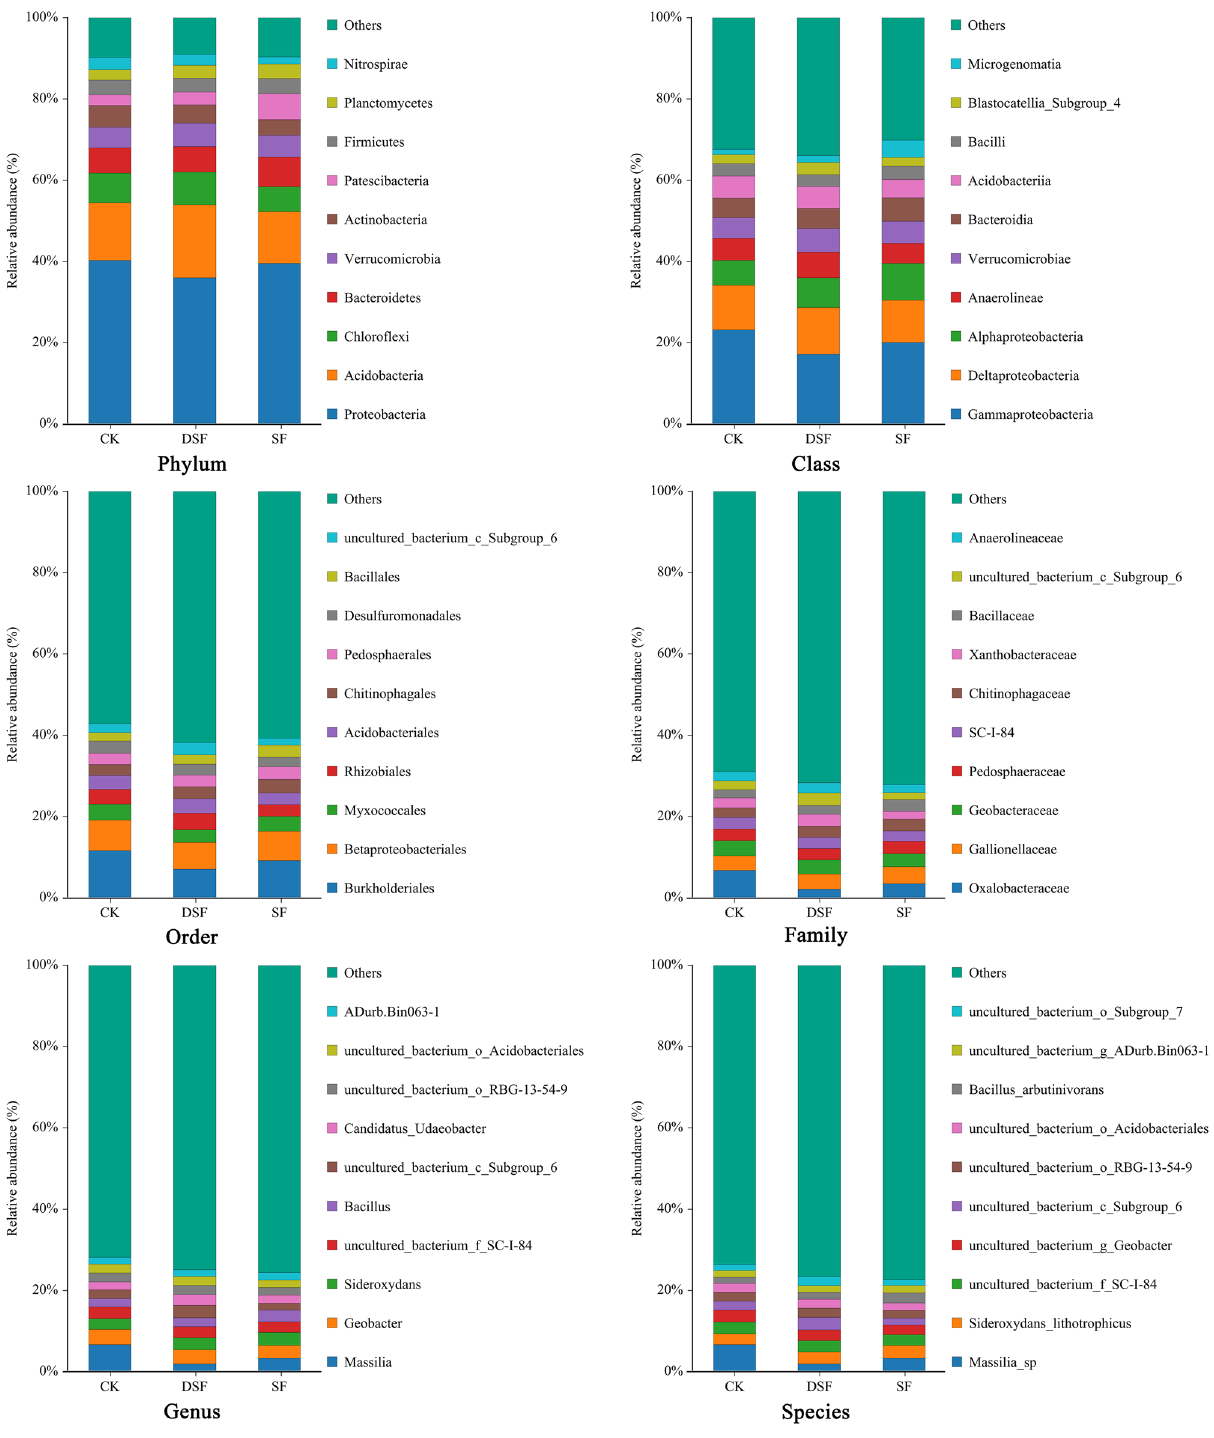
Figure 3. Species distribution at each level of rice rhizosphere microorganisms under different fertilization modes of slow-release fertilizer. Values are the mean of three